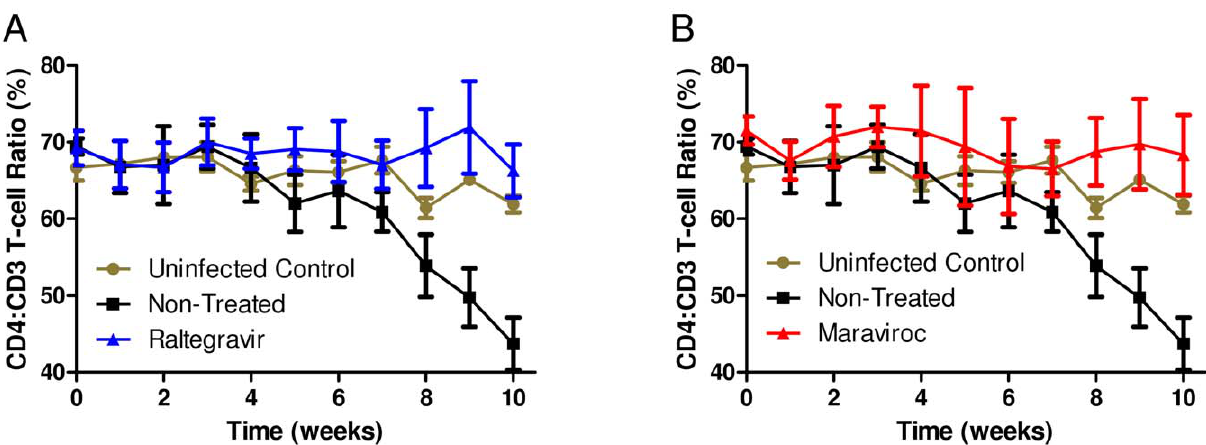
Figure 4. CD4 T cell decline in non-treated vaginally challenged mice in contrast to mice protected with raltegravir and maraviroc treatment. Levels of CD4 T cells were monitored on a weekly basis by FACS to determine their decline in treated versus non-treated mice. Baseline values for each of the mice were established prior to infection as described in Methods. A. Raltegravir treated, B. Maraviroc treated.